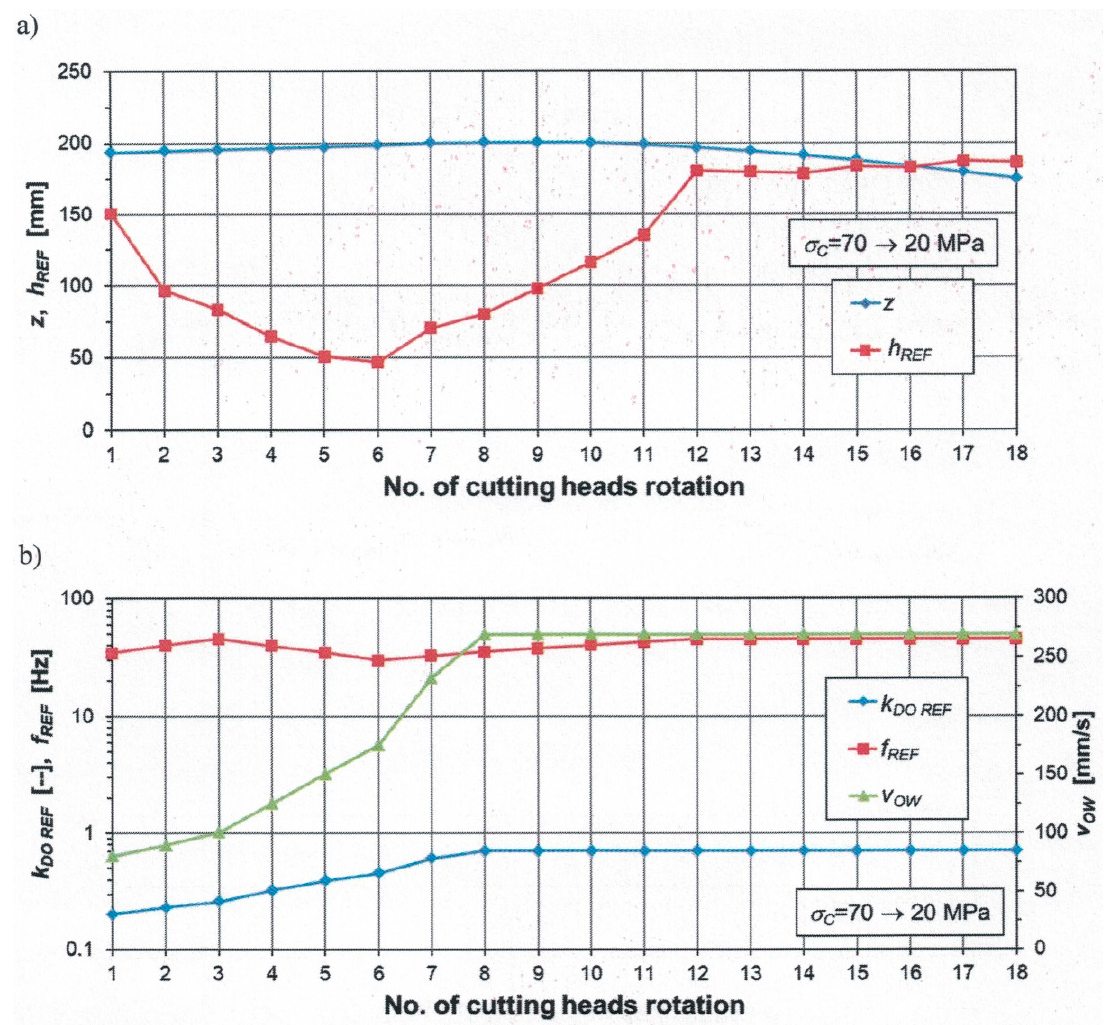
Figure 10. The course of cutting parameters: ( a ) web of cut ( z ) and set cut height ( h REF ) and ( b ) cutting heads movement speed ( v OW ), and set values: supply voltage frequency ( f REF ) and electrohydraulic valve opening coefficient ( k DO REF ) in subsequent rotations of the cutting heads when making lower cuts in the automatic control mode in rocks with decreasing uniaxial compressive strength.